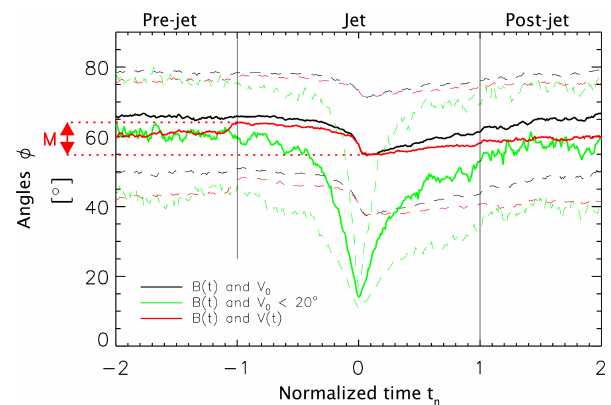
Figure 3. Superposed epoch analyses of the angles φ B , V in red, φ B , V in black, and φ B , V of those jets where that angle is limited 0 0 to 20 ◦ at t n = 0 in green. Solid lines show median values; dashed lines show upper- and lower-quartile values. Red dotted lines mark minimum and maximum values of median φ B , V angles: the differ- ence between these two values is M B , V = 9 . 4 ◦